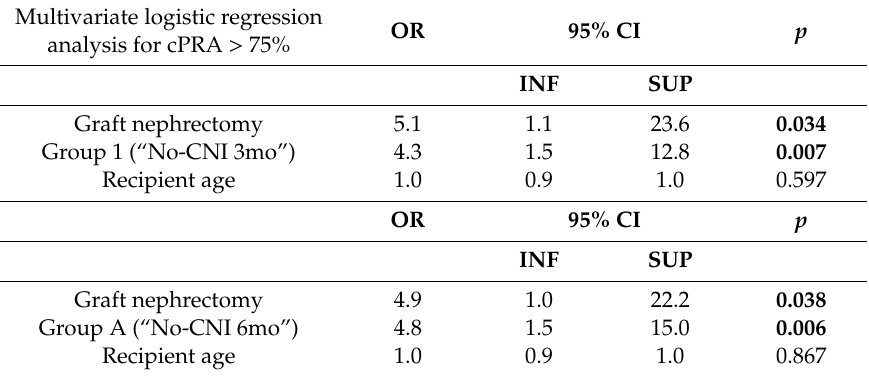
Figure 2. Patients with/without calcineurin inhibitor (CNI) maintenance at 6 months and cPRA after transplant failure. No CNI maintenance at 6 months after graft failure (group A) was associated with cPRA >75% significantly ( p = 0.001). Table 2. Results of the multivariate logistic regression analysis for cPRA > 75%. The bold: p values less than 0.05 defined statistical significance.